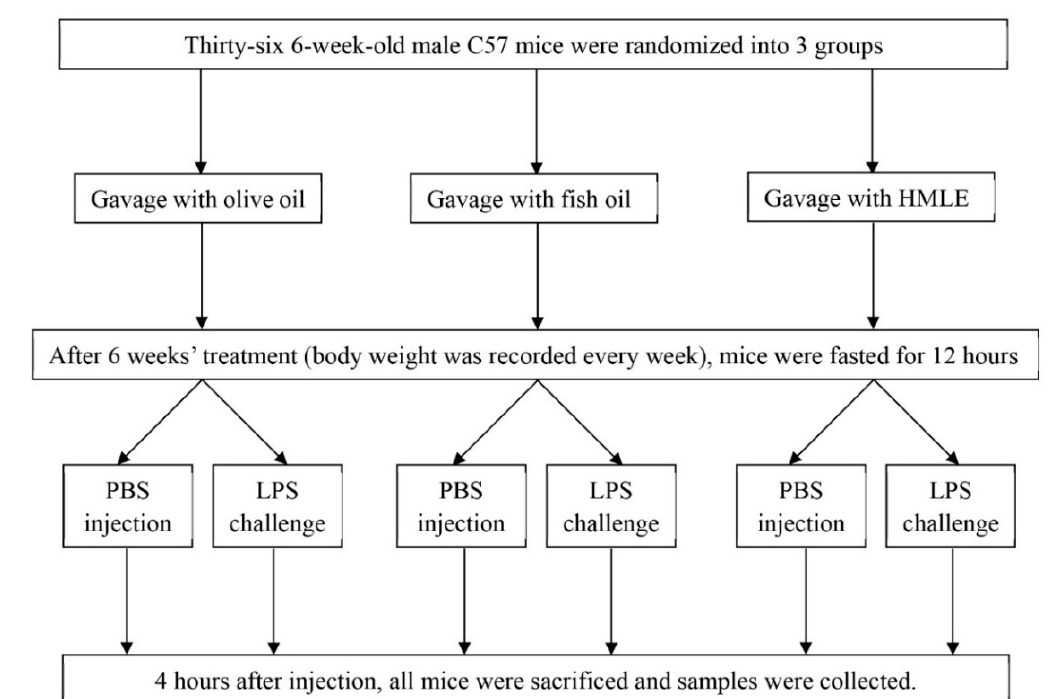
Figure 1. Schematic of study design.